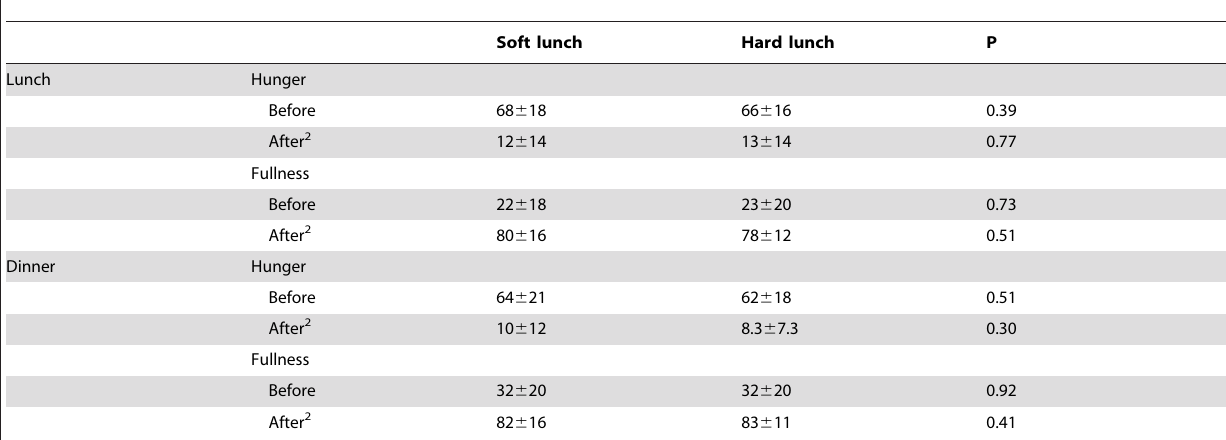
Table 2. Hunger and fullness ratings before and after lunch and dinner.